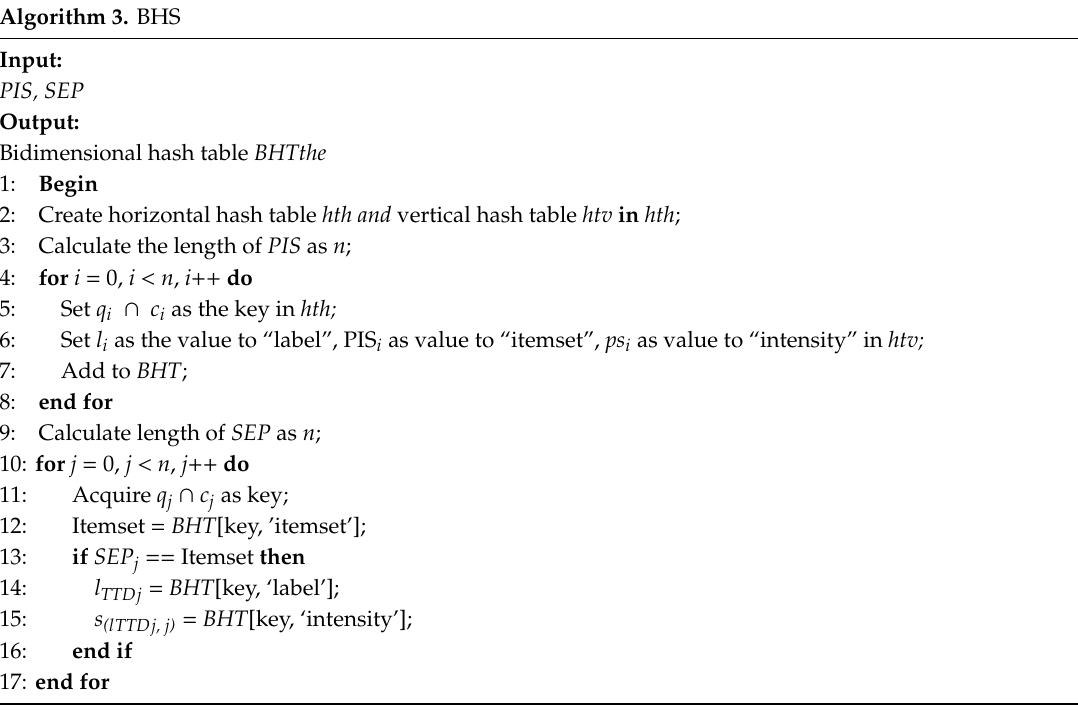
Algorithm 3. BHS